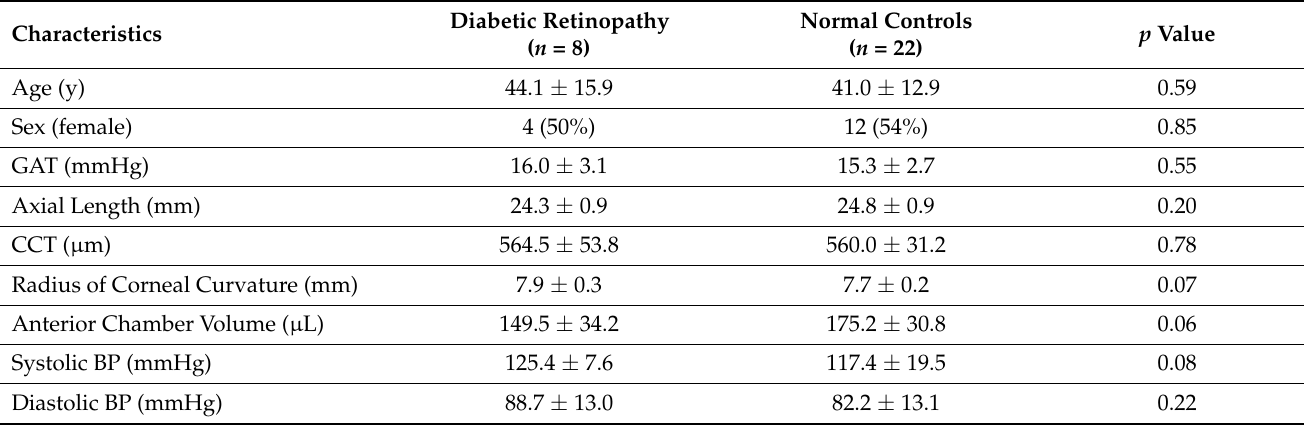
Table 1. The clinical characteristics of all participants ( n = 30) and their statistical distribution.